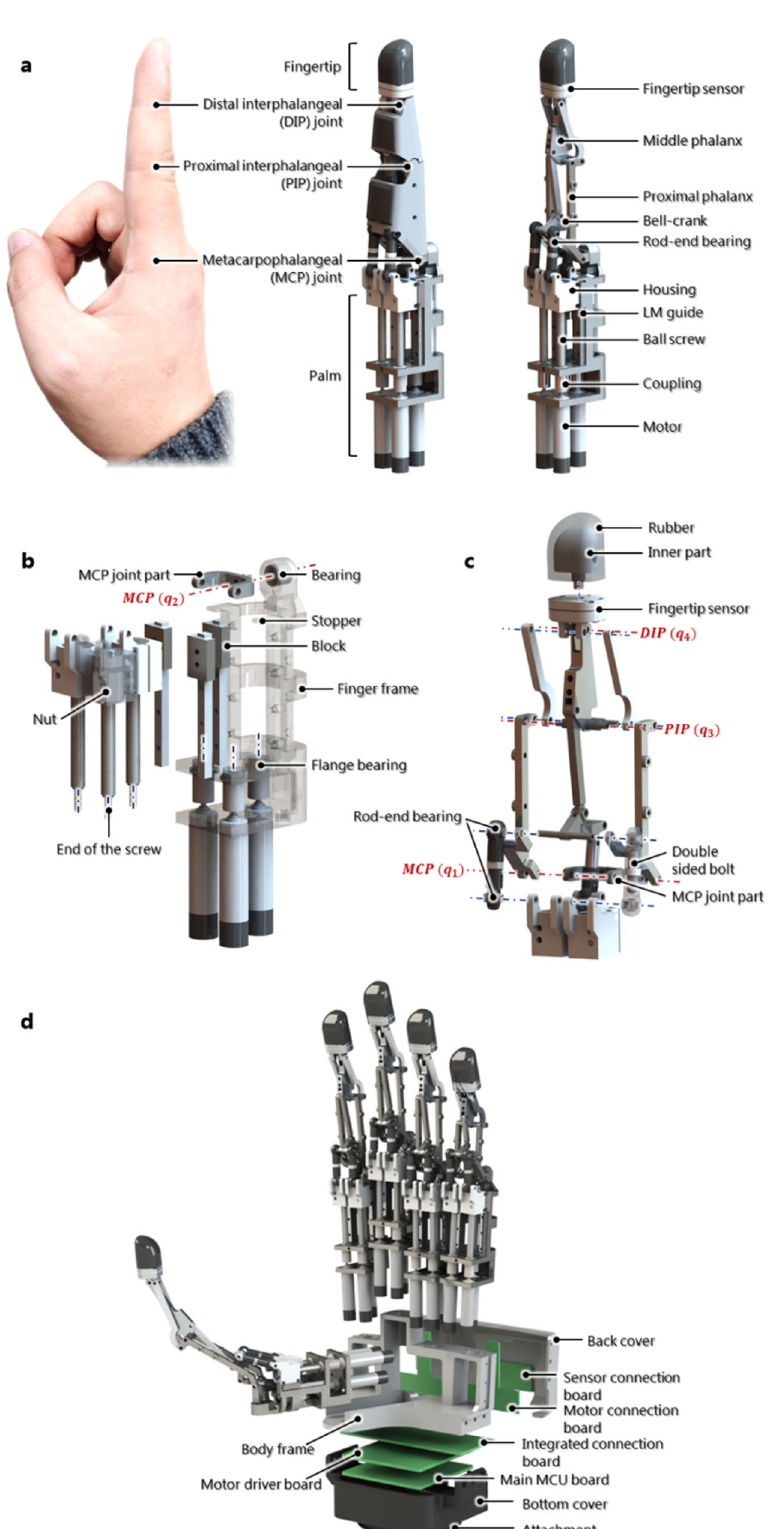
Fig. 4 Structure of the robotic fi nger designed based on the proposed mechanism. a Con fi guration of the robotic fi nger. b Exploded view of the palm side of the fi nger. c Exploded view of the upper portion of the palm side. d Con fi guration of the ILDA hand. The hand includes the fi ve fi ngers, three connection boards, a motor driver board, and a main MCU